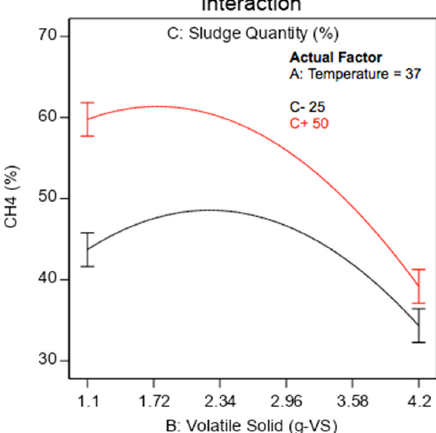
(13) Table 8. ANOVA table for CO 2 % response. Source